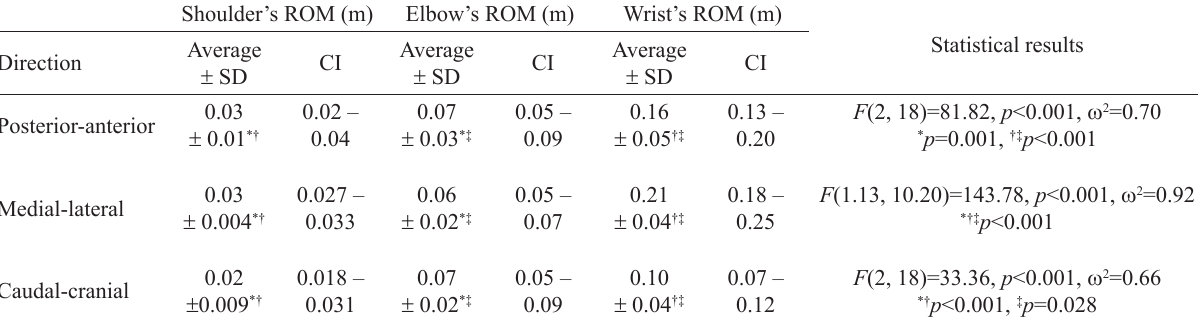
Table 4. Average, standard deviation (SD), lower and upper boundaries of confidence interval (CI) of shoulder, elbow and wrist’s linear range of motion (ROM) for each direction and statistical results of the comparison between the joints’ ROM in each direction. The same superscript sign indicates differences between joints’ ROM in the same